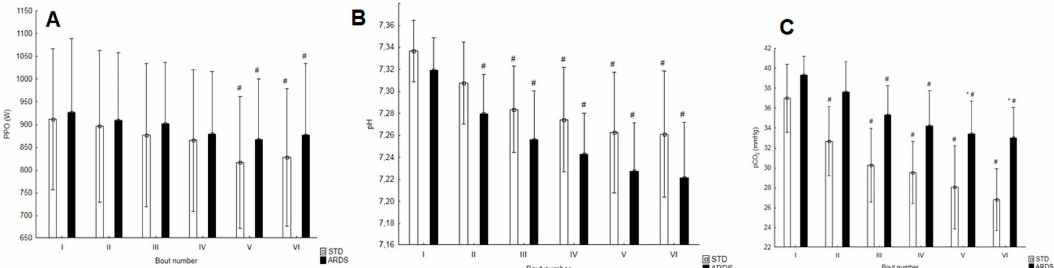
Figure 3. Changes in ( A ) peak power output (PPO), ( B ) pH values, and ( C ) carbon dioxide partial pressure (pCO 2 ) in the subsequent bouts during SIE sessions. # Statistically significant di ff erence as compared with the first bout ( p < 0.05), * Statistically significant di ff erence between the SIE protocols.